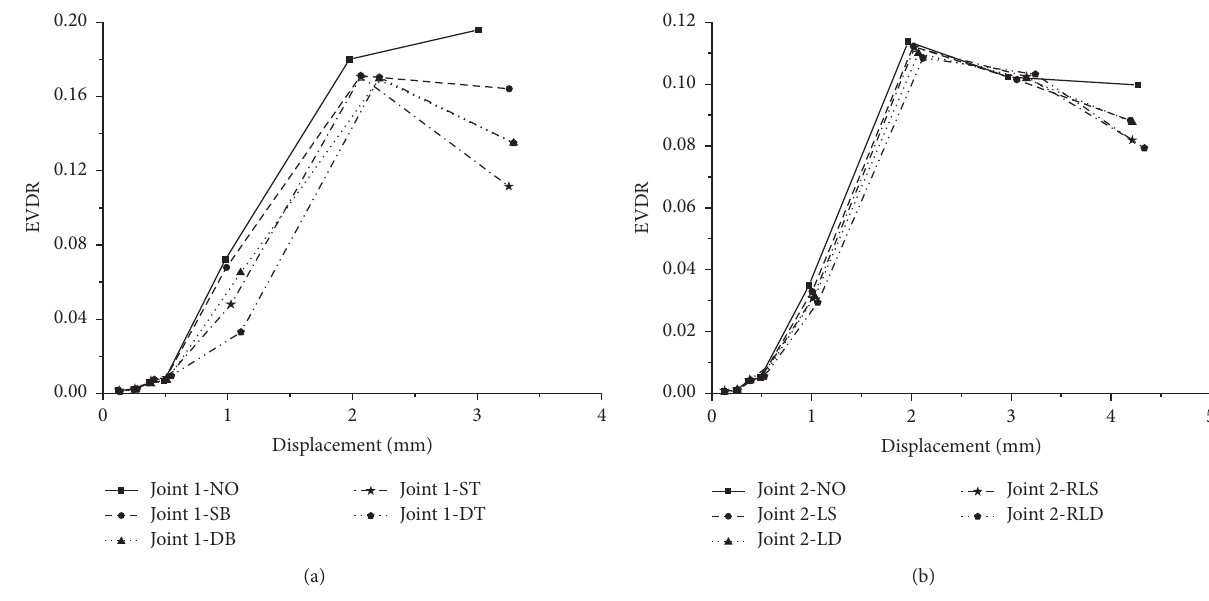
Figure 22: Relationships between equivalent viscous damping ratio and displacement: (a) Joint 1; (b) Joint